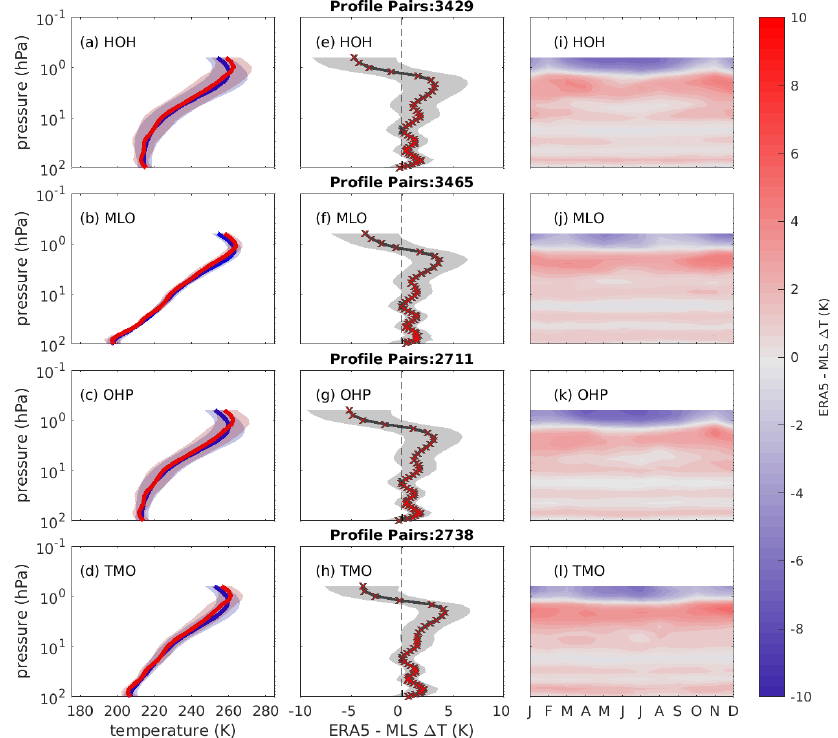
Figure 5. Mean profiles of matched temperatures from ERA5 (blue) and EOS MLS passes (red)at (a) Hohenpeissenberg, (b) Mauna Loa, (c) Observatoire de Haute-Provence and (d) Table Mountain Observatory between 1990 and 2017. Shading depicts 1 standard deviation in the mean temperature. The vertical profiles of the mean of the differences between ERA5 and EOS MLS are shown in (a–d) are shown in (e–h) respectively; shading shows 1 standard deviation of mean difference. Crosses are red for model levels where the mean of the differences are different from zero at the 95% significance level. Panels (i–l) show the temperature differences as a function of month and pressure level for each of the lidars shown in panels (a–d)